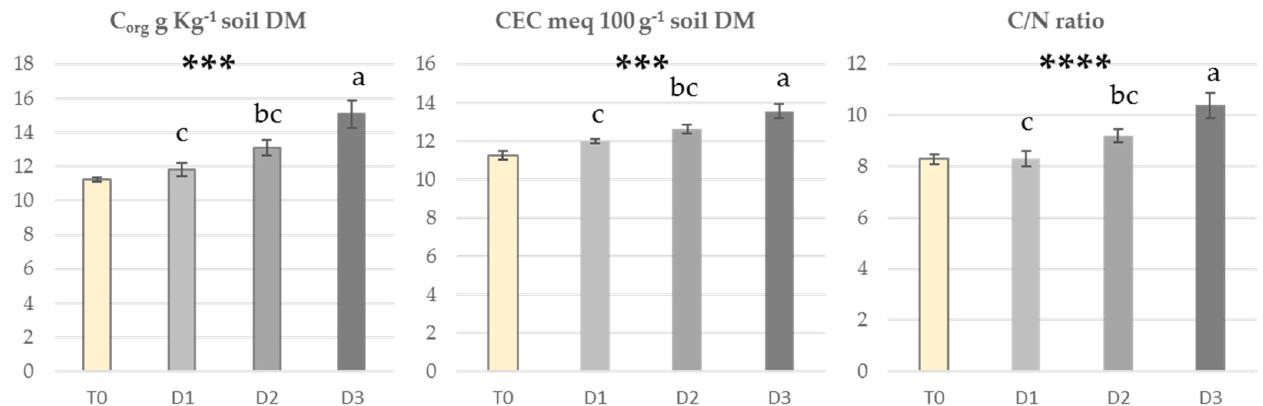
Figure 5. Effect of biochar application rates (D1 = 10, D2 = 20, D3 = 40 t ha − 1 DM) on the soil chemical parameters C org , CEC and C-to-N ratio after maize harvesting in 2019; the T 0 value for the same parameters is also indicated. Biochar dose source of variation; *** significant at 0.005 level, **** significant at 0.001 level. a,b,c Mean comparison by linear contrasts.